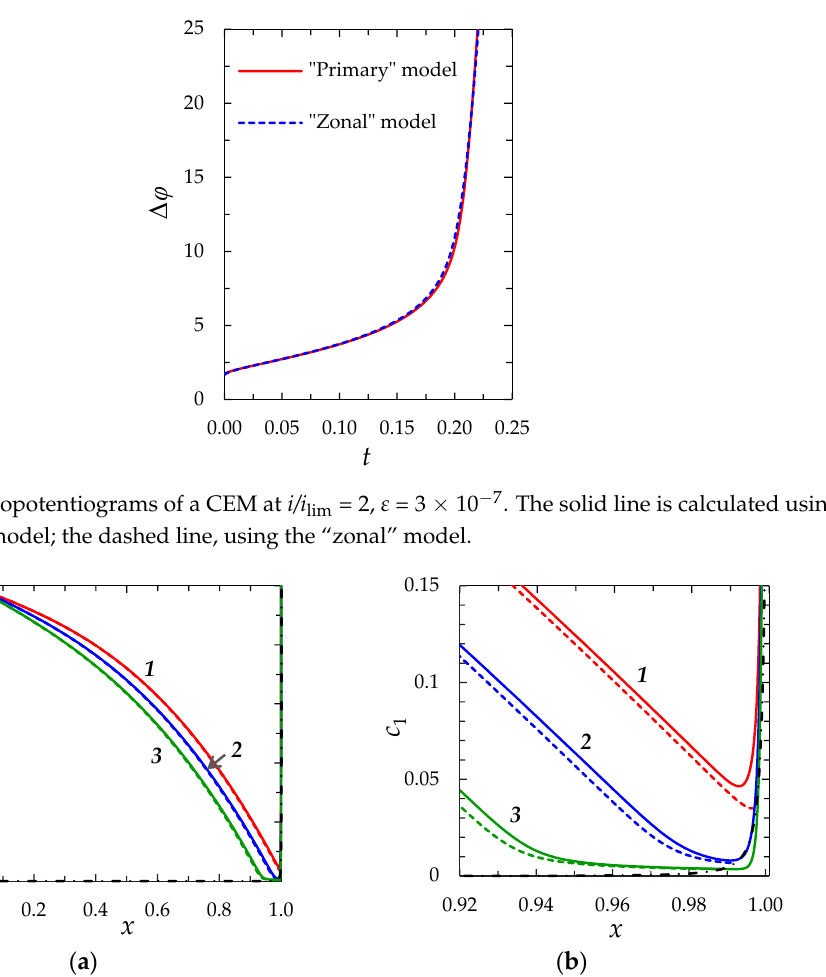
Figure 5. ( a ) Concentration profiles of cations near a CEM for ε = 3 × 10 − 7 and i /i lim = 2 at three different instants of time: t = 0.189 (1), 0.213 (2) and 0.240 (3). The solid lines are calculated numerically using the “primary” model (the region of applicability 0 ≤ x ≤ 1), the dashed lines are calculated numerically using the “zonal” model in the region 0 ≤ x ≤ 1 − δ 3 , the dash-dotted line is the result of calculation of c 1 by Formula (22) (the region of applicability is 1 − δ 3 ≤ x ≤ 1); ( b ) enlarged fragment of ( a ).